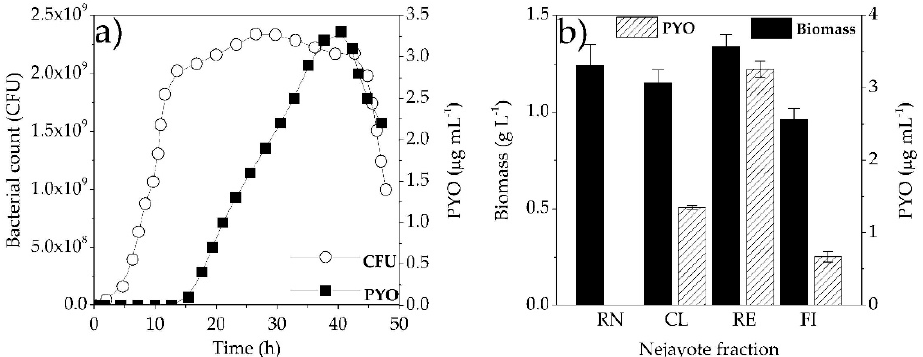
Figure 3. ( a ) Microbial growth kinetics and PYO production of Pseudomonas aeruginosa NEJ01R under optimized growth conditions; ( b ) biomass and PYO production of P. aeruginosa NEJ01R using raw nejayote (RN) and fractions (clarified (CL), retentate (RE) and filtered (FI) fractions) under optimized conditions.